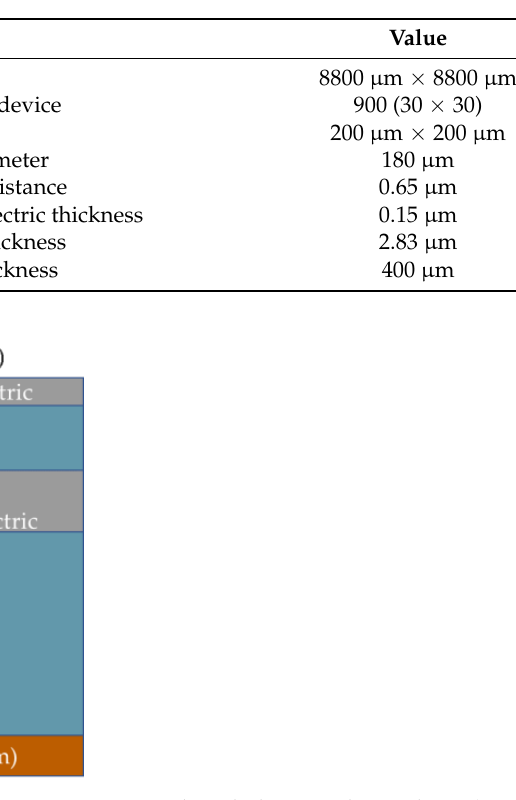
Figure 1. Cross-section of a single capacitive micromachined ultrasound transducer (CMUT) cell.